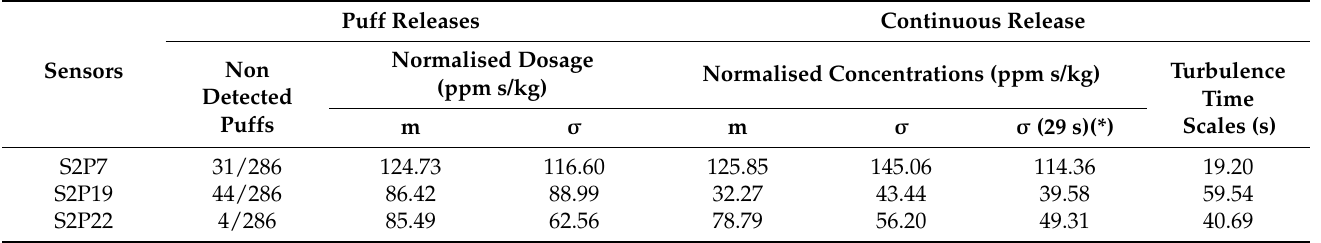
Table 1. The S2 Michelstadt experiment: data for the 286 puff releases and the continuous release (for the puff releases m = D / QT and σ = σ D / QT ; for the continuous release m = CS / Q , σ = σ CS 0 / Q and σ ( 29 s ) = σ CS ( 29 s ) / Q ). Puff Releases Continuous Release Normalised Dosage Non Sensors Normalised Concentrations (ppm s/kg) (ppm s/kg) Detected Puffs